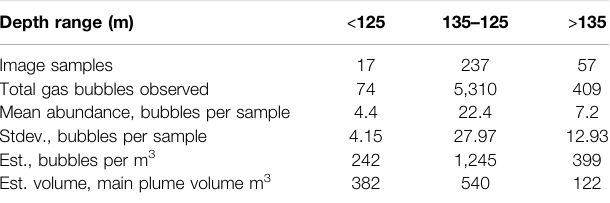
TABLE 2 | Summary of gas bubble abundances observed in image samples from the bubblometer in three depth ranges of hydrocarbon plume, as counted by the R-CNN